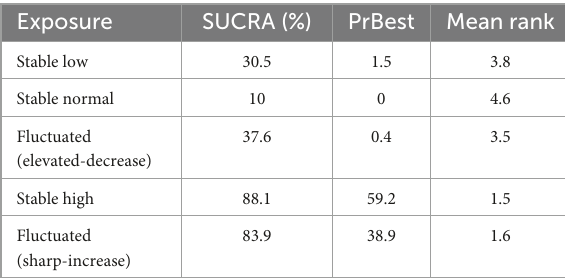
TABLE 3 Surface under the cumulative ranking curve area (SUCRA) values for various